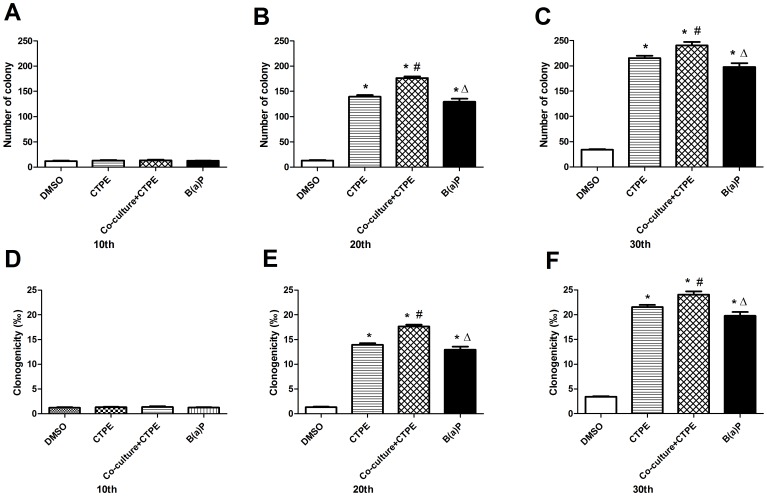
The number of colony and percentage of colonies formation of BEAS-2B cells in soft agar.The number of colony (A–C) and clongenicity percentage (D–F) were significantly increased in Co-culture/CTPE group compared to those of other three groups at passage 20, or passage 30. (n = 6, *: vs DMSO, P<0.05; #: vs CTPE, P<0.05; Δ:vs Co-culture+CTPE, P<0.05).Values were the mean±SD of three independent experiments.